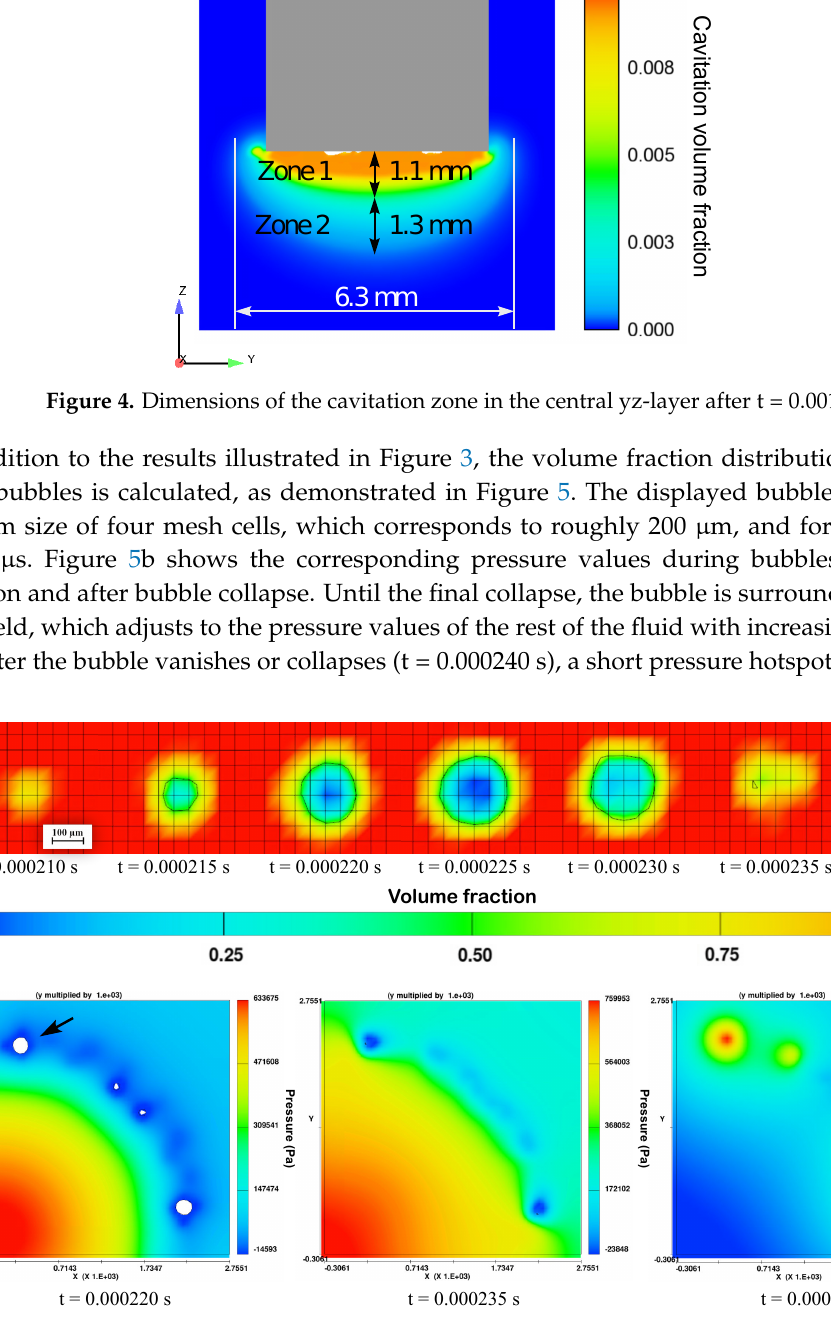
Figure 5. Bubble dynamics: ( a ) fluid fraction in and around the bubble and ( b ) pressure conditions in the area around the bubble and after